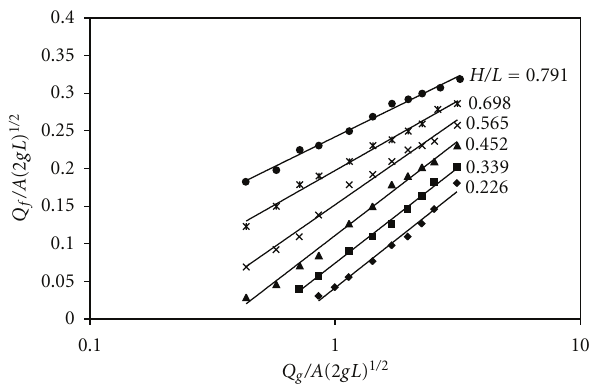
(cid:6) 2 gL with log